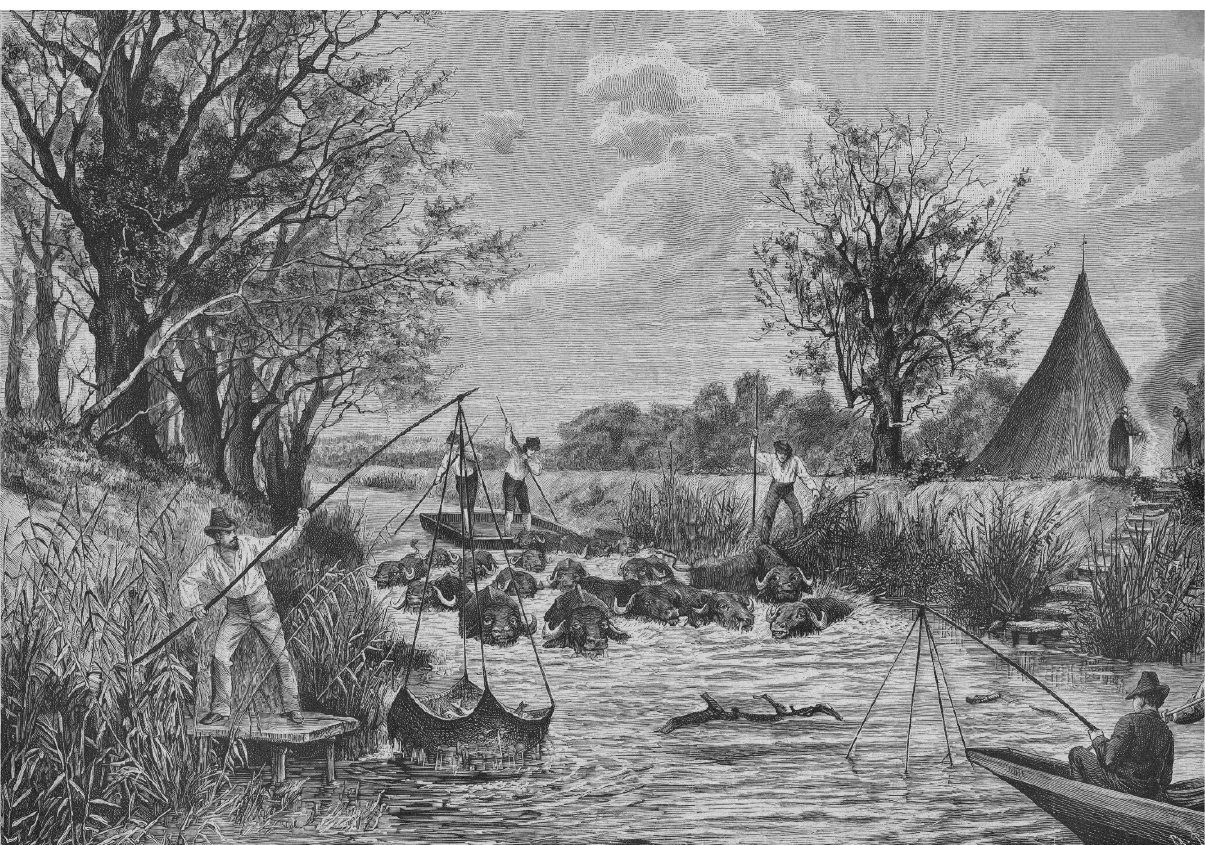
Figure 4. Water buffalo had already been introduced into the central Italian Pontine marshes in the late 19 th century, where they were used both for grazing and for other tasks. Engraving of a drawing from 1888 by Franz Oskar Bernhard Schreyer